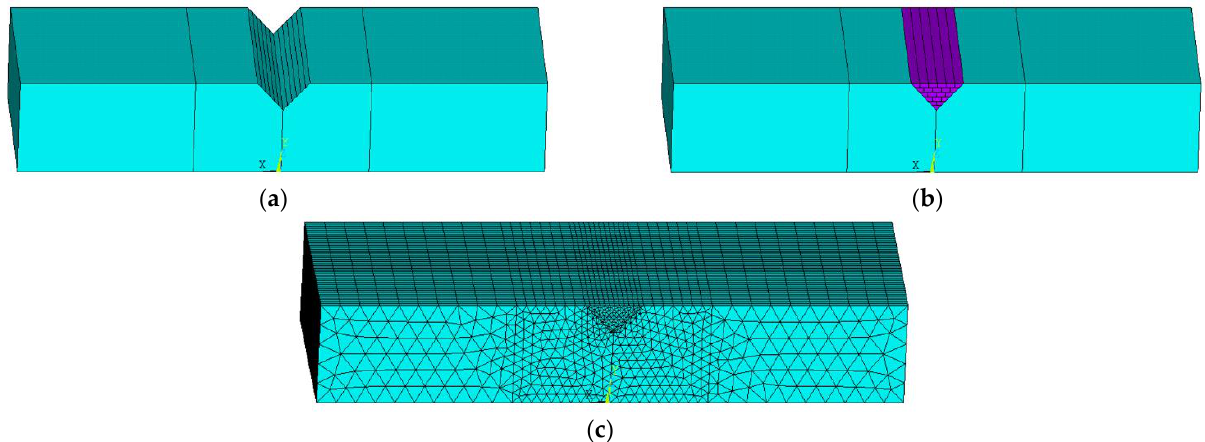
Figure 6. ( a ) FEA model geometry of the damaged part; ( b ) laser scan strategy for repair; ( c ) finite element mesh for directed energy deposition (DED) process simulation. Table 4. Input parameters for the numerical simulation.